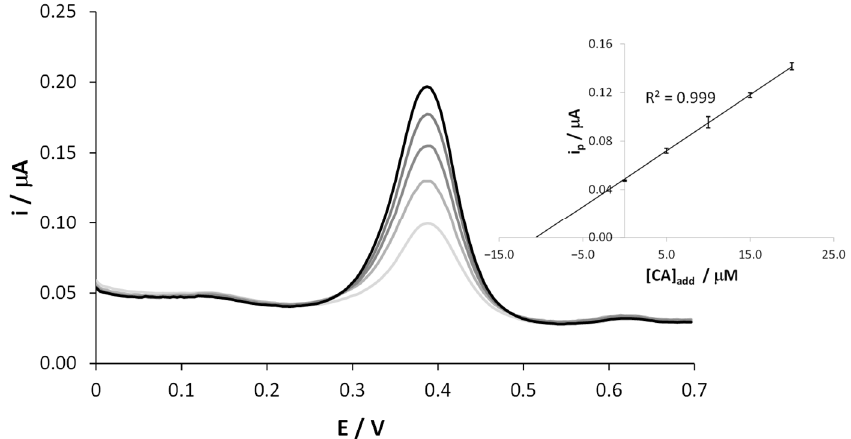
Figure 4. Representative DPV scans recorded at SNGC-CB electrodes in a coffee sample, diluted 1:1000 in 0.1 M AB pH = 4.0 solution, as it is and after 4 subsequent standard additions of CA. Inset: calibration curve.